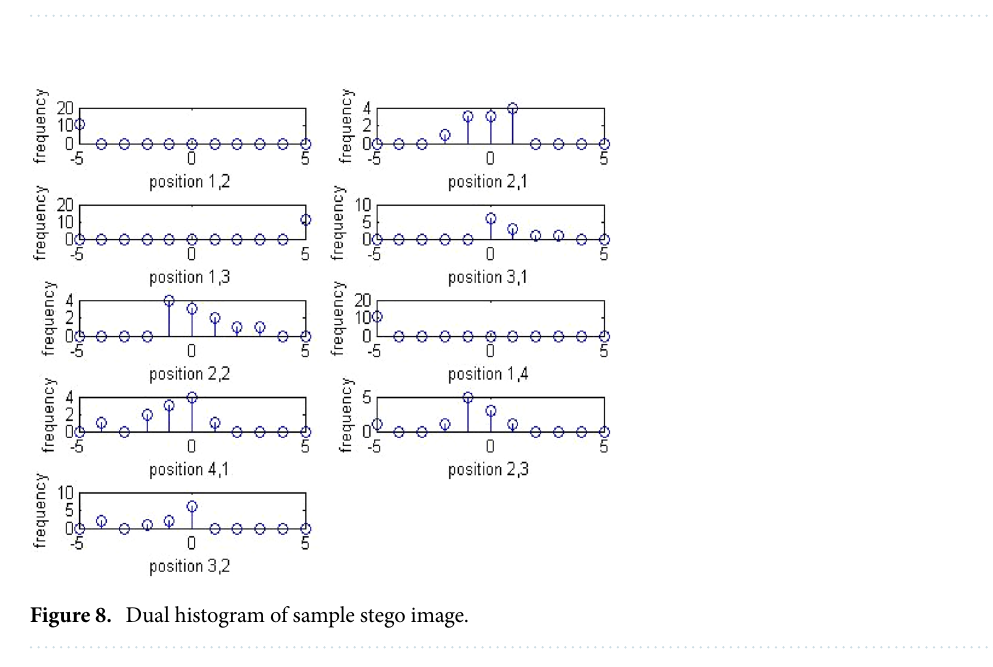
Figure 7. Global histogram of sample calibrated stego image.